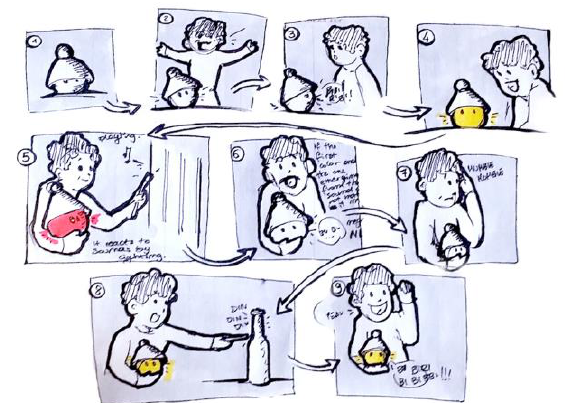
Figure 5 | Storyboard sketches of the artefact’s concept. The sequence shows a child playing with Shybo, by making sounds and observing its